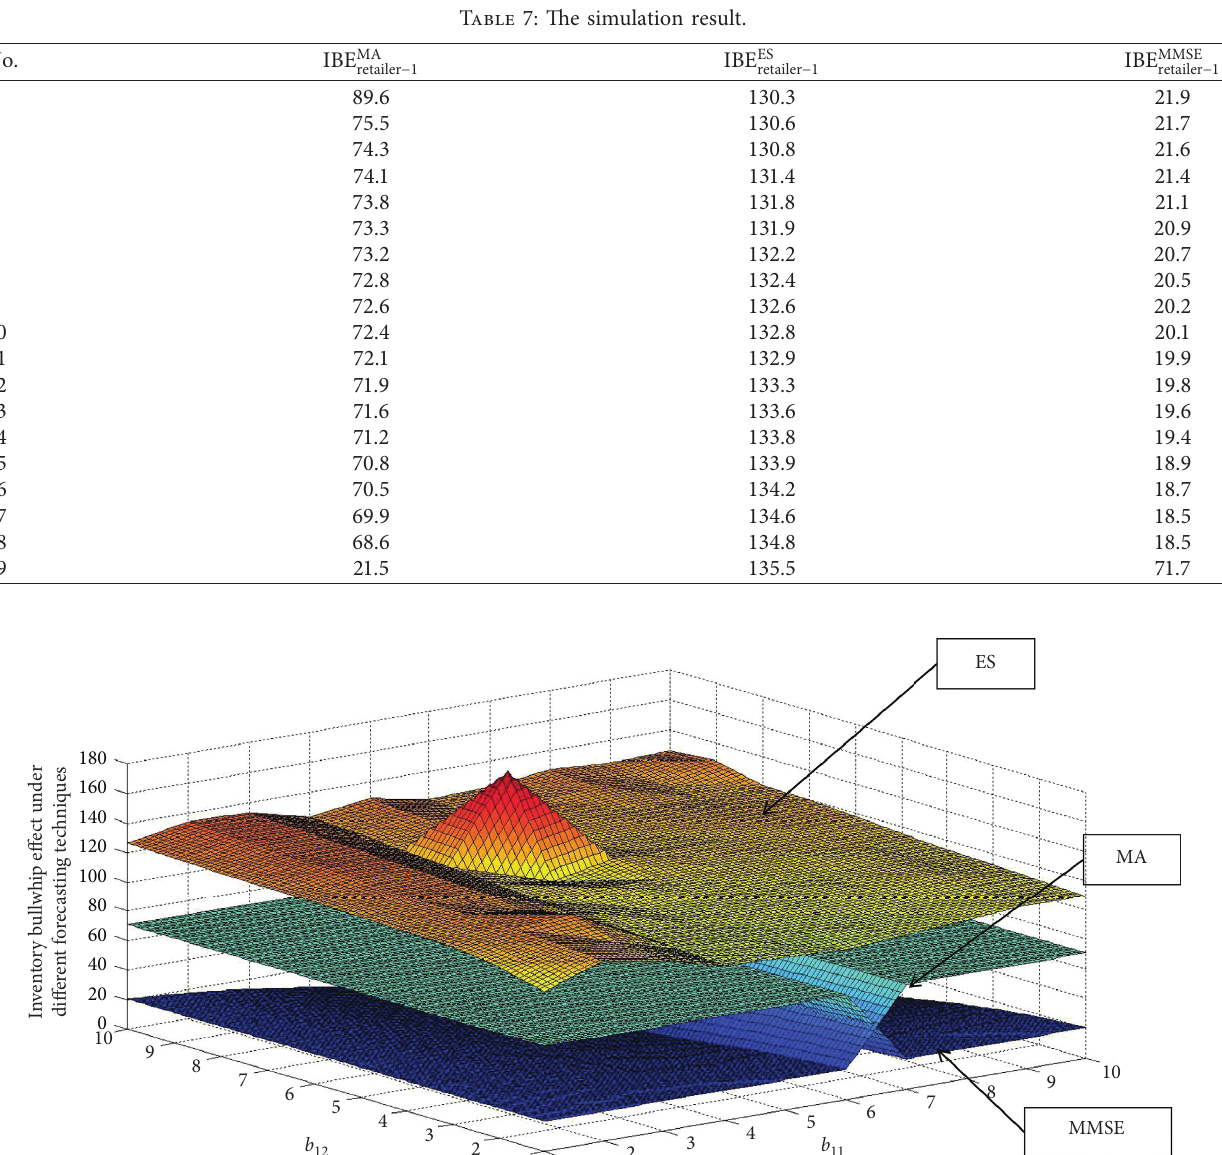
and b on the inventory bullwhip effect using different forecasting 11 12